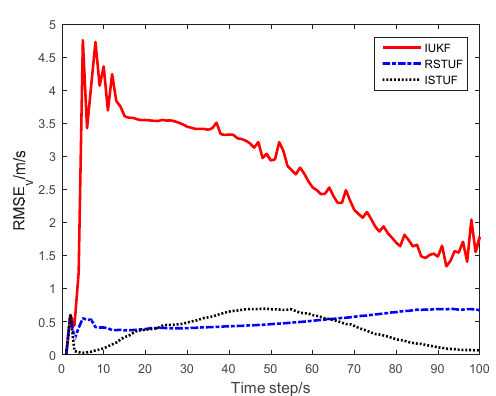
Figure 2. RMSE of estimating position.